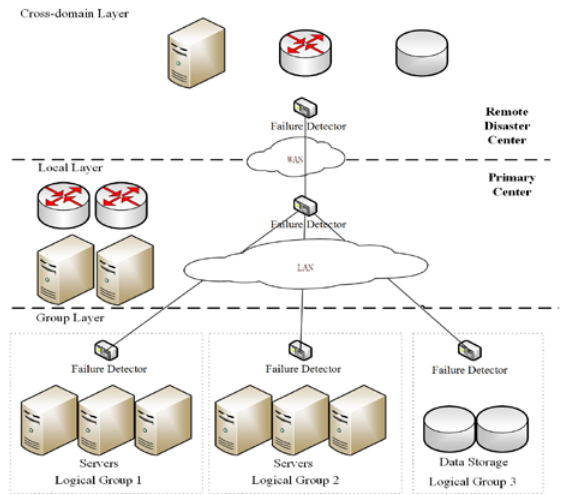
Fig. 2. Failure detection